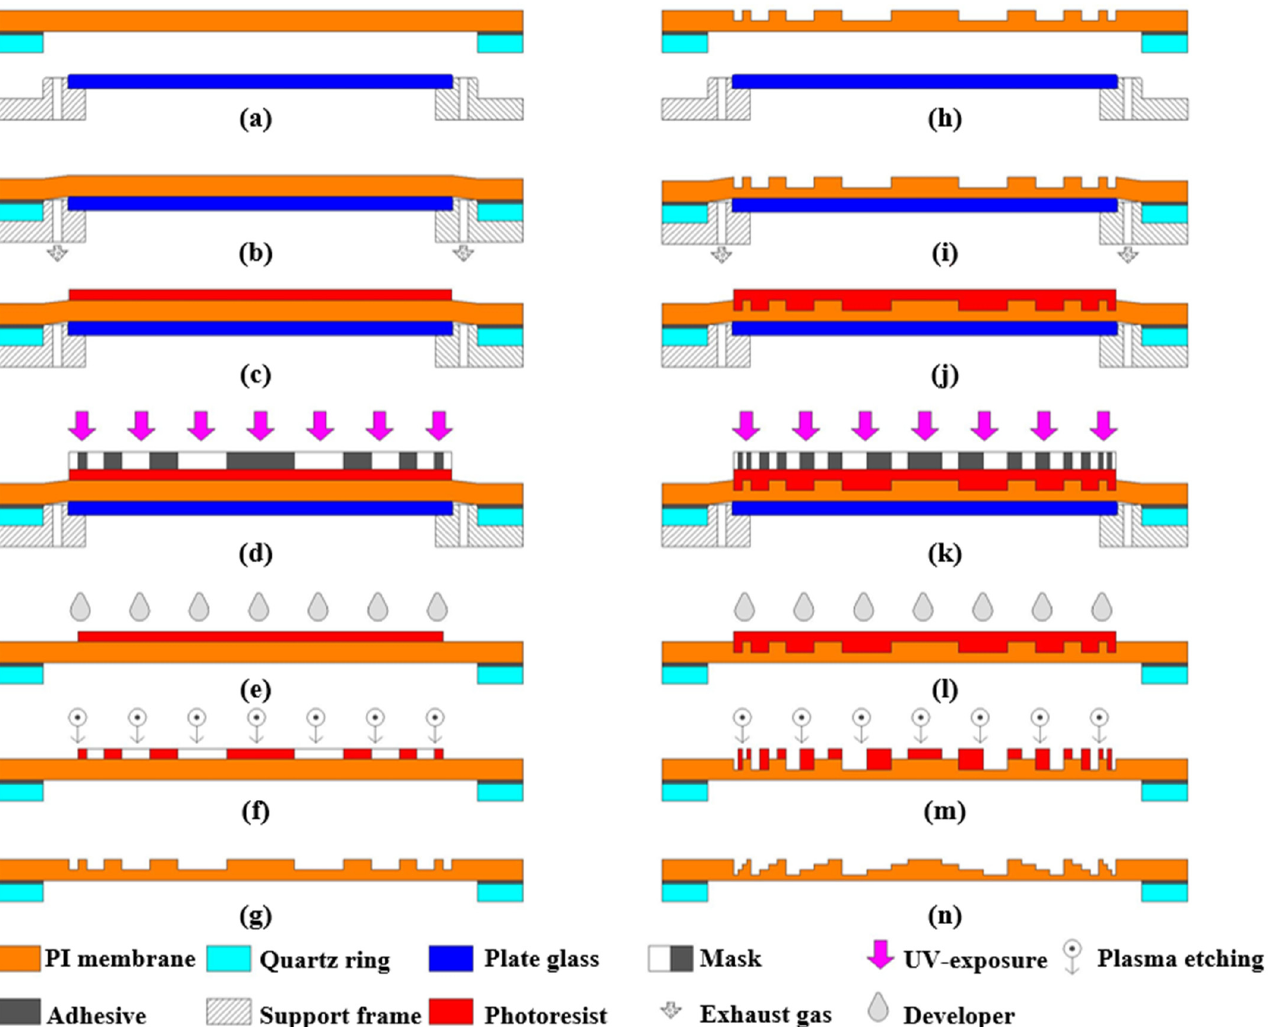
Figure 4. Schematic of the technical process. ( a ) The silica-framed membrane mirror and supporting plate glass. ( b ) The membrane is attached to flat glass with no gap. ( c ) First spin-coating. ( d ) Contact exposure. ( e ) First development. ( f ) First reactive ion etching. ( g ) Two-level Fresnel diffractive microstructure. ( h ) The silica-framed membrane mirror and supporting plate glass. ( i ) The membrane is attached to flat glass with no gap. ( j ) Second spin-coating. ( k ) Overlay exposure. ( l ) Second development. ( m ) Second reactive ion etching. ( n ) Four-level Fresnel diffractive microstructure.